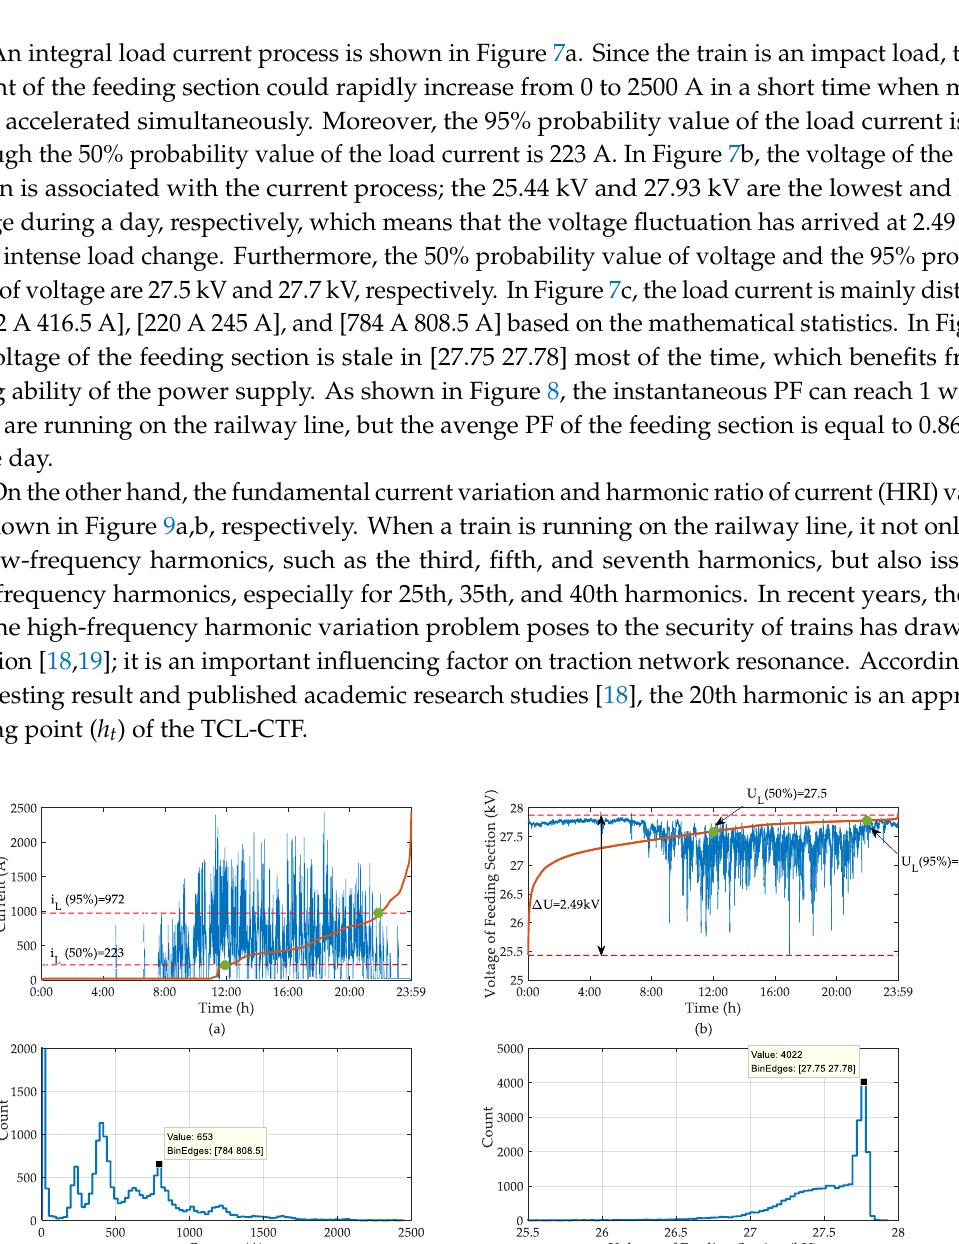
. Figure 8. Power factor (PF) distribution and power consumption of the α feeding section. . Figure 9. Harmonic ratio of current (HRI) variation. ( a ) Current process of traction load; ( b ) HRI process of traction load between the second and 50 th harmonic order.